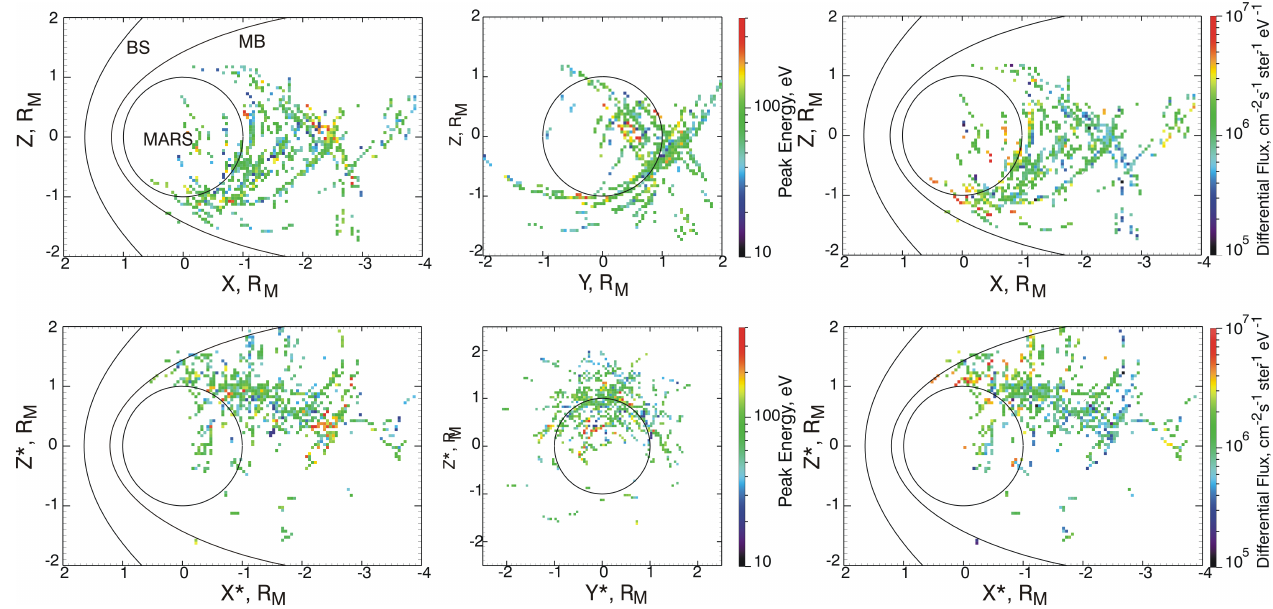
Fig. 14. (top) Maps of the events with peaked electron spectra in MSO coordinates, (bottom) maps in the coordinate system determined by the IMF direction. Color shows the peak energy of electrons (left and middle panels) and the differential flux corresponding to the peak energies (right